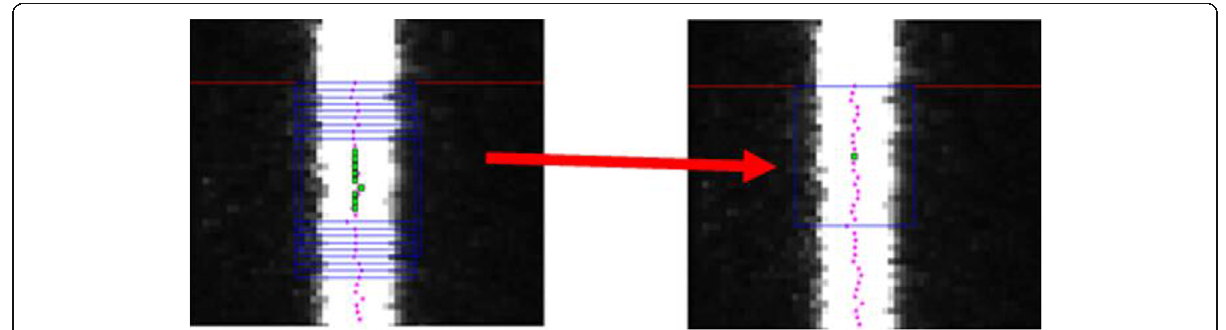
Fig. 8 Gradient window. a The local gradient image window. b A single gradient window